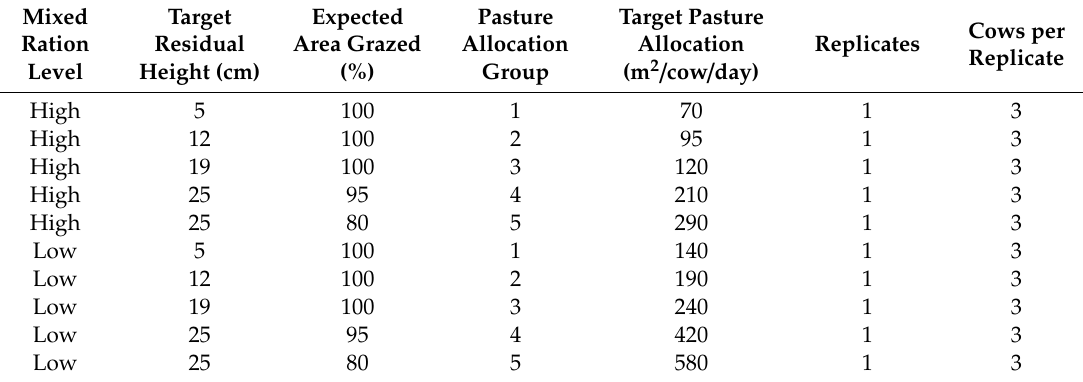
Table 1. Outline of Pasture × Mixed Ration level treatments for thirty multiparous